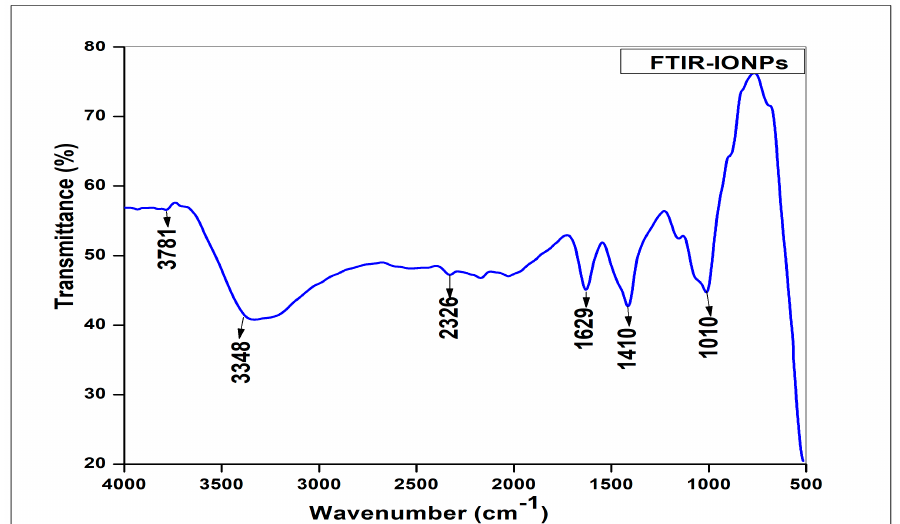
Figure 3. FTIR spectra showing different functional groups involved in the biosynthesis of IONPs.